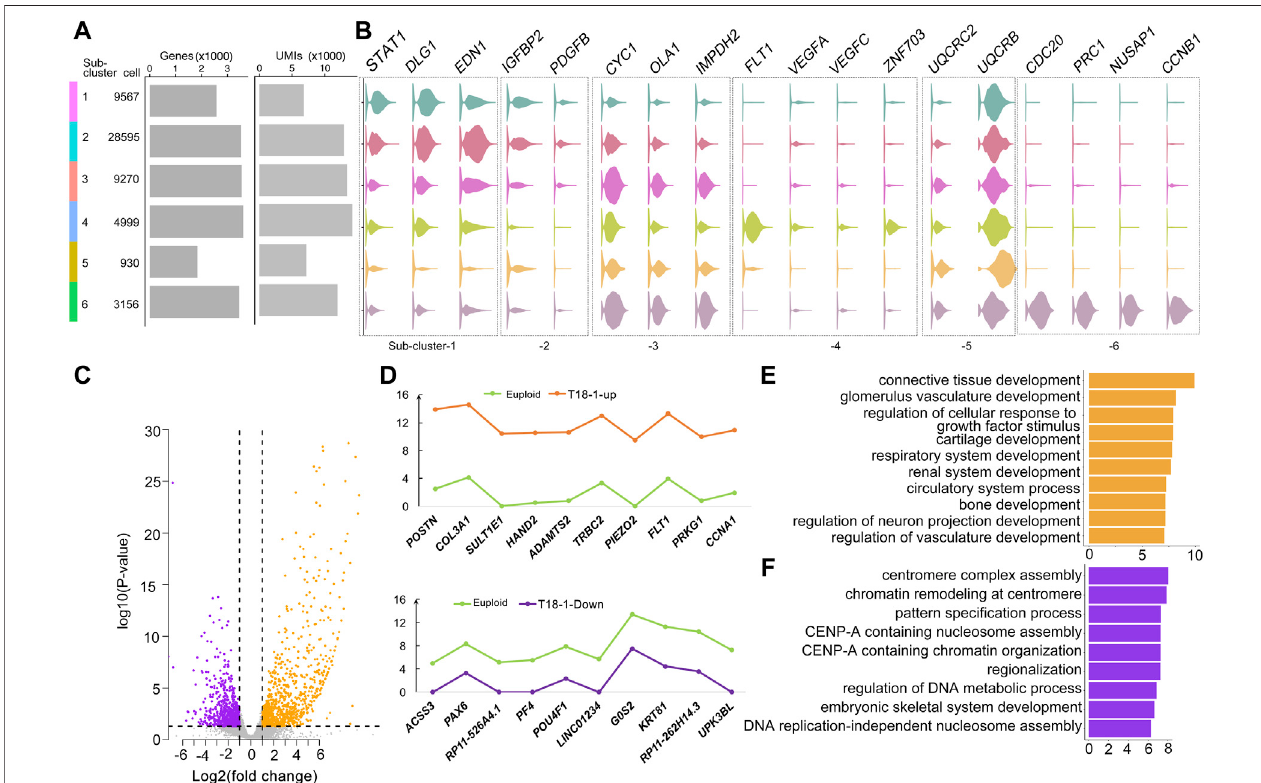
FIGURE 2 | Altered genes in trisomy 18 amniotic fl uid cells. (A) Dendrogram of 6 sub-clusters, cell number per sub-cluster, number of genes in each sub-cluster ( p < 0.01),anduniquemolecularidenti fi ers(UMIs). (B) Violinplotsofrepresentativegenesidenti fi edin6sub-clusters. (C) Volcanoplotofdifferentiallyexpressedgenesby comparingtheT18-1witheuploidsamples.Up-regulatedgenes:orangedots;down-regulatedgenes:purpledots. (D) Top10( − log2foldchange > 1andFDRcorrected p ≤ 0.05) up-regulated genes (orange), down-regulated genes (purple) in the T18-1 sample compared with two euploid samples (green). (E) Gene ontology (GO) analysis of up-regulated genes in T18-1 cells compared with two euploid samples. (F) GO analysis of down-regulated genes in 18T-1 cells compared with two euploid samples.